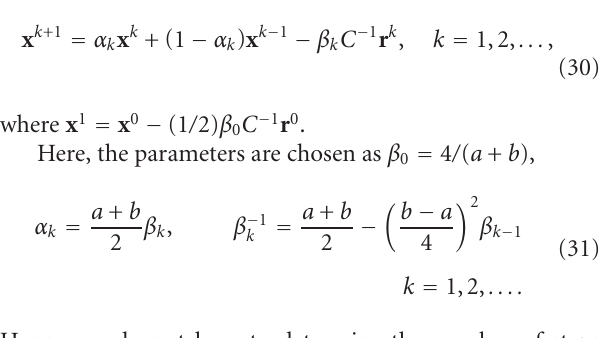
Algorithm 1: Standard conjugate gradient